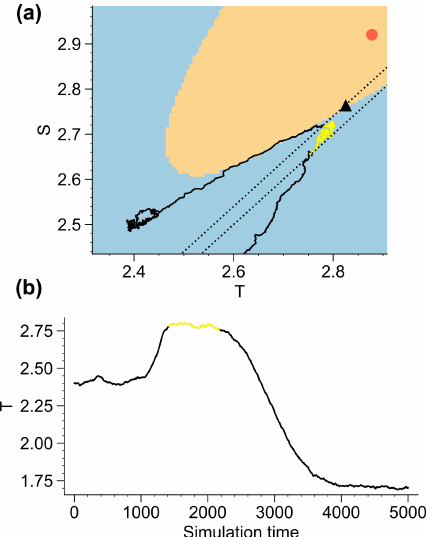
Figure 13. (a) Simulation in phase space of the Stommel model with σ T = σ S = 0 . 2, where η 1 is ramped from η 1 = 2 . 65 to η 1 = 3 . 00 within 300 years. The two dotted lines correspond to the levels q = T − S = 0 . 06 and q = T − S = 0 . 1. The trajectory in between the first crossing of these two thresholds is shown in yellow. (b) Corresponding time series of the variable T .